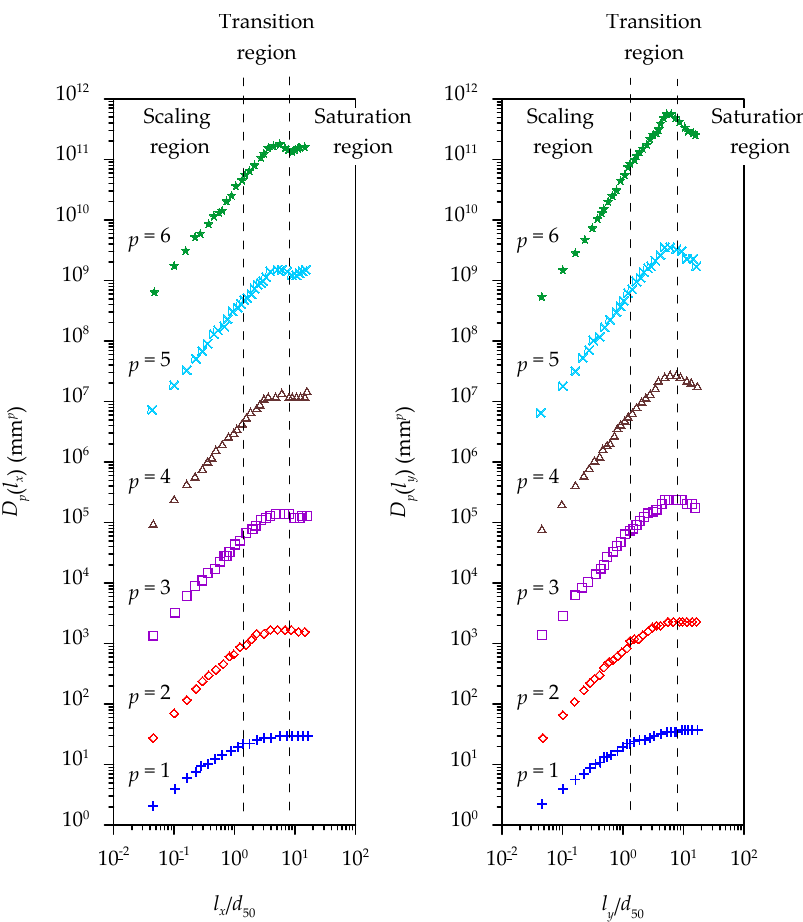
Figure 4. Non-dimensional structure function of a WGB (data extracted from Nikora and Walsh [17]).